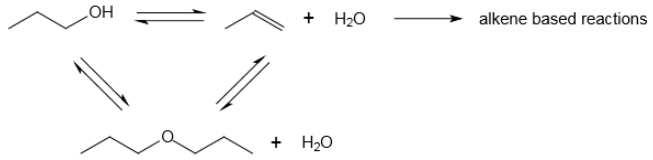
Figure 6. Reaction network of alcohol to hydrocarbon conversion illustrated using 1-propanol; the reaction network shown does not reflect stoichiometry.